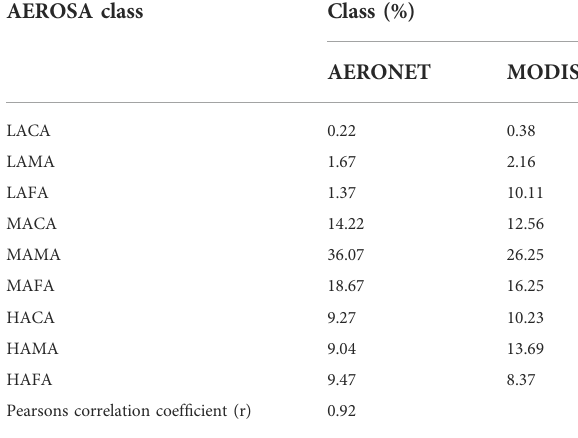
TABLE 7 Comparison of the AEROSA genericclasses using MODIS and AERONET AOD and